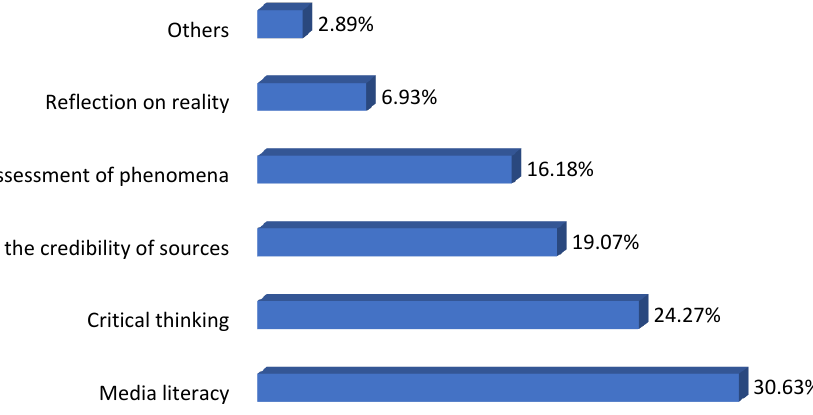
Figure 2. Research of the most important skills for building users´ real resilience (n = 173).